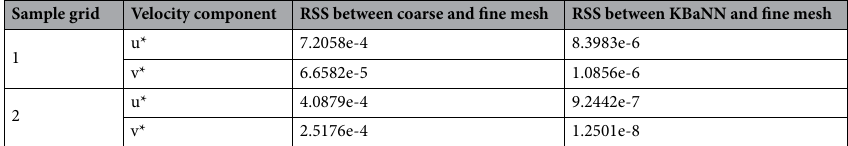
Table 1. The residual sum of squares (RSS) between the KBaNN predictions and the fine mesh for each of the sample grids pictured in Fig. 5. The corrections made by the KBaNNs greatly improve the accuracy of the solution.